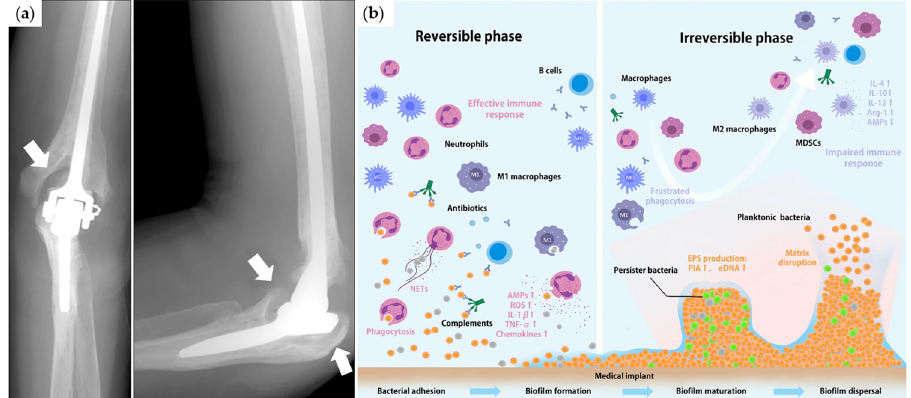
Figure 8. Challenges for bone (and dental) implants: ( a ) aseptic loosening of the implant commonly occurring due to “stress shielding”. Reprinted with permission from ref. [241]. Copyright 2019 by the Korean Orthopaedic Association. This is an open-access article distributed under the terms of the Creative Commons Attribution Noncommercial License (https://creativecommons.org/licenses/by-nc/4.0/); ( b ) occurrence of inflammation and biofilm formation. If osseointegration fails when host cells do not strongly attach to the implant, microbes can colonize the surface, leading to biofilm formation and inflammation. Reprinted (adapted) from ref. [38]. Copyright 2022, The Au-